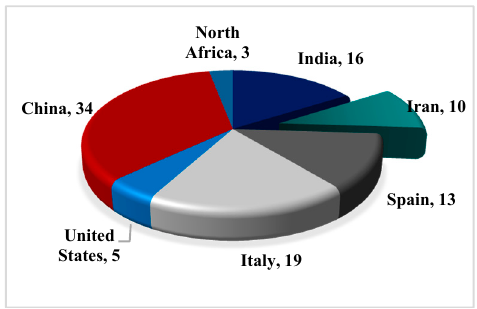
Figure 1. Stone production of different countries/regions (%) [5] .